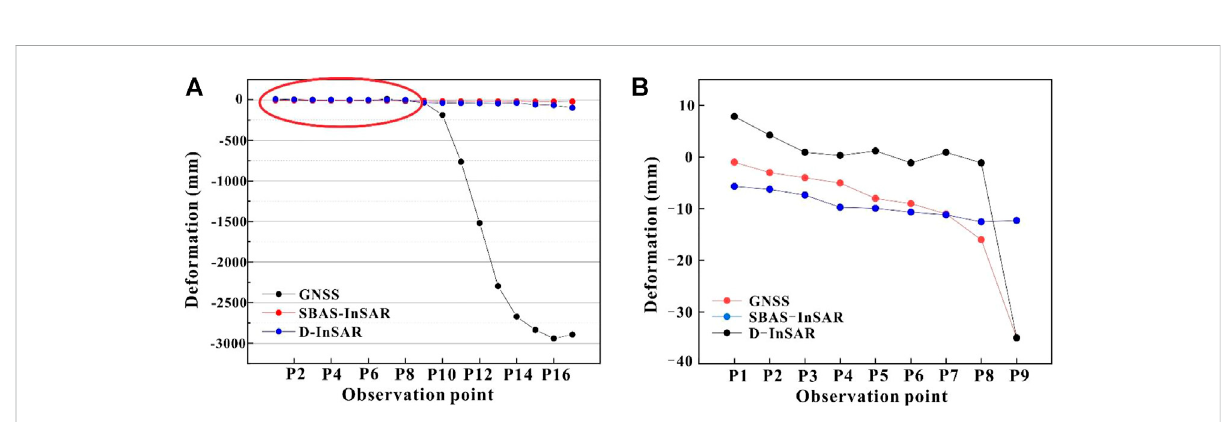
FIGURE 10 (A) Comparison of the GNSS results with the SBAS-InSAR and continuous D-InSAR results in the measured trend line (P1 – P17), (B) Local enlargement at the red circle in (A)